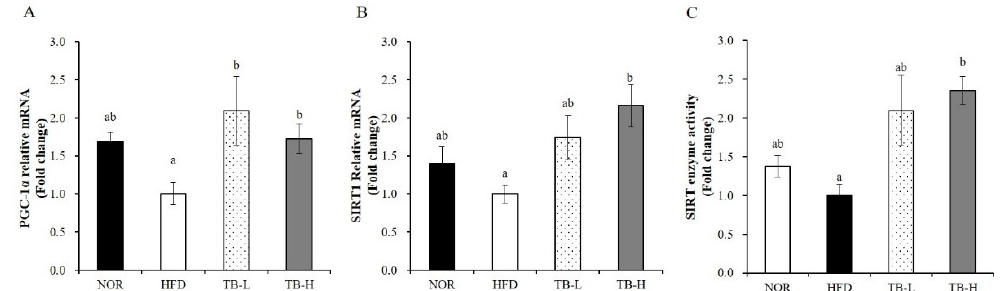
Figure 6. The effect of tartary buckwheat extract on muscle mitochondrial gene expression and sirtulin 1 (SIRT1) enzyme activity. The mRNA levels of PGC-1 α ( A ) and SIRT1 ( B ) were analyzed by real-time PCR and normalized to GAPDH. SIRT enzyme activity was measured by a colorimetric SIRT activity assay kit ( C ). Data are expressed as mean ± SEM ( n = 8). Values with different letters are significantly different at p < 0.05. NOR: normal diet; HFD: 45% high-fat diet; TB-L: HFD + 0.5% TB; TB-H: HFD + 1.0% TB.